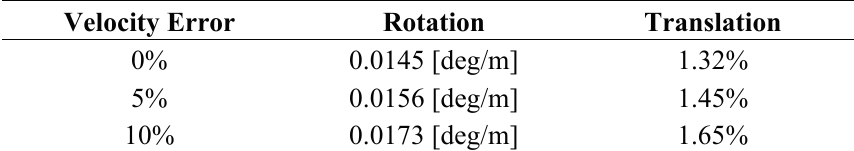
Table 4. Average performance of MYP against velocity error.